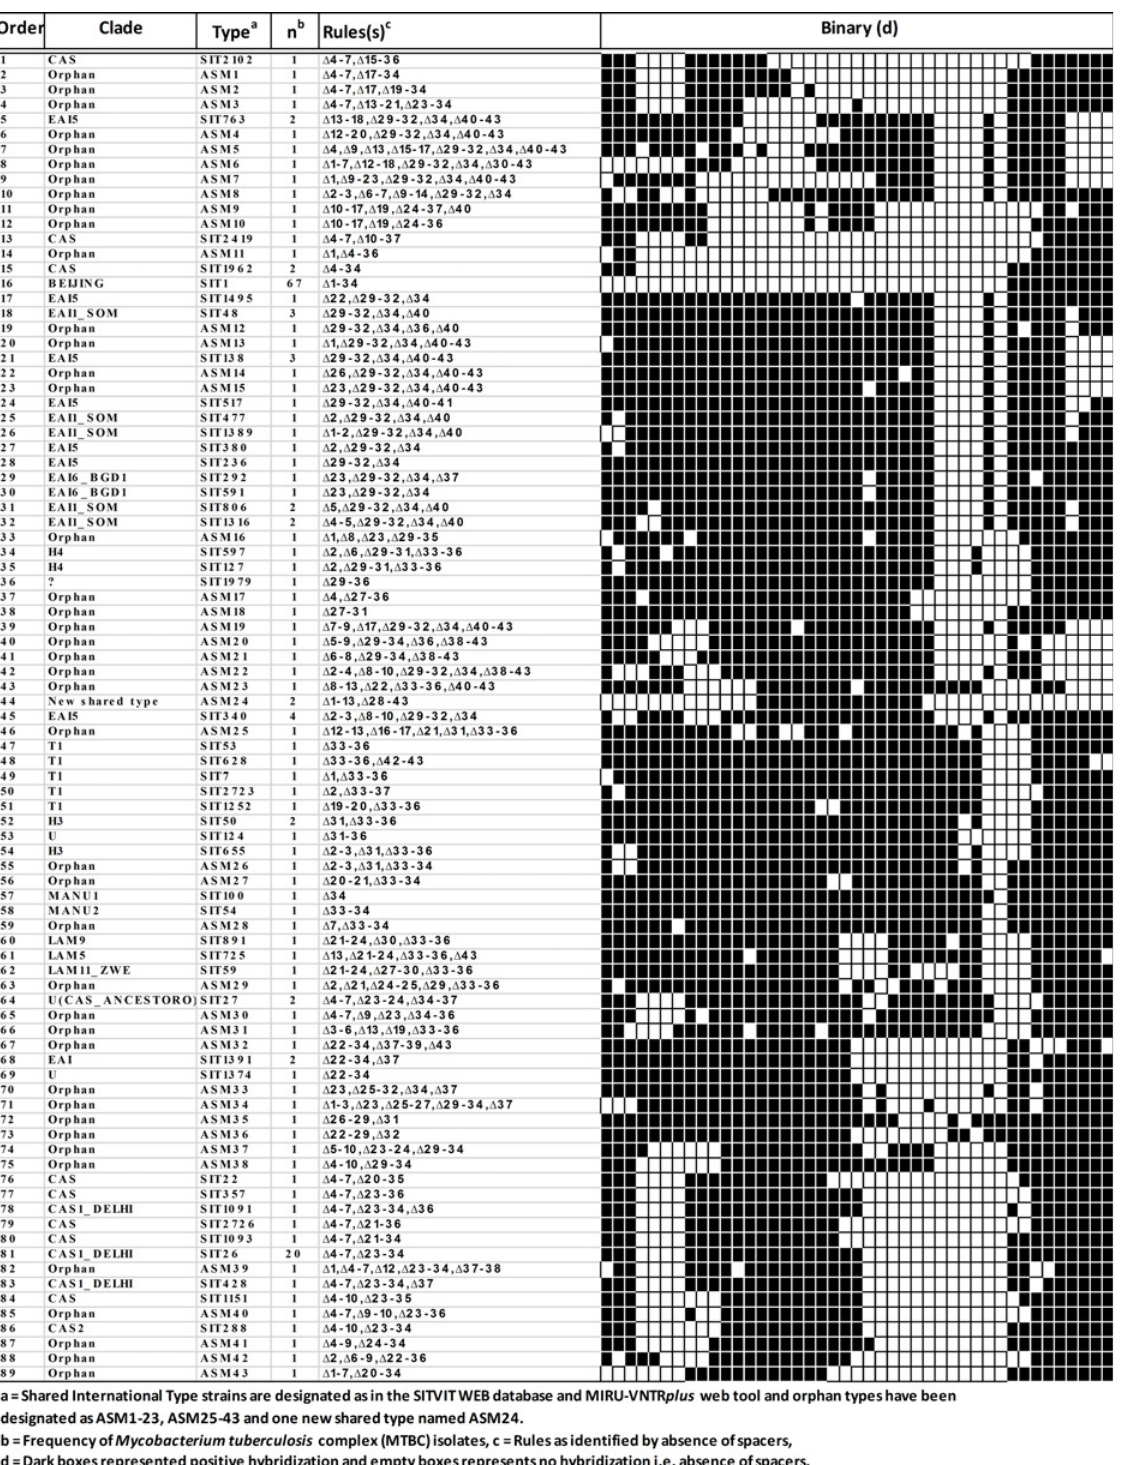
Fig 1. Spoligotype patterns of MTBC circulating in Assam.